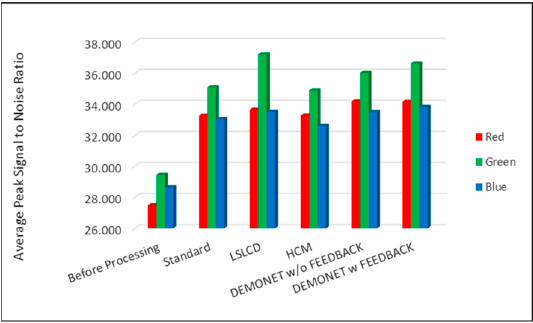
Figure 13. Averaged PSNR values of different methods for RGB bands.